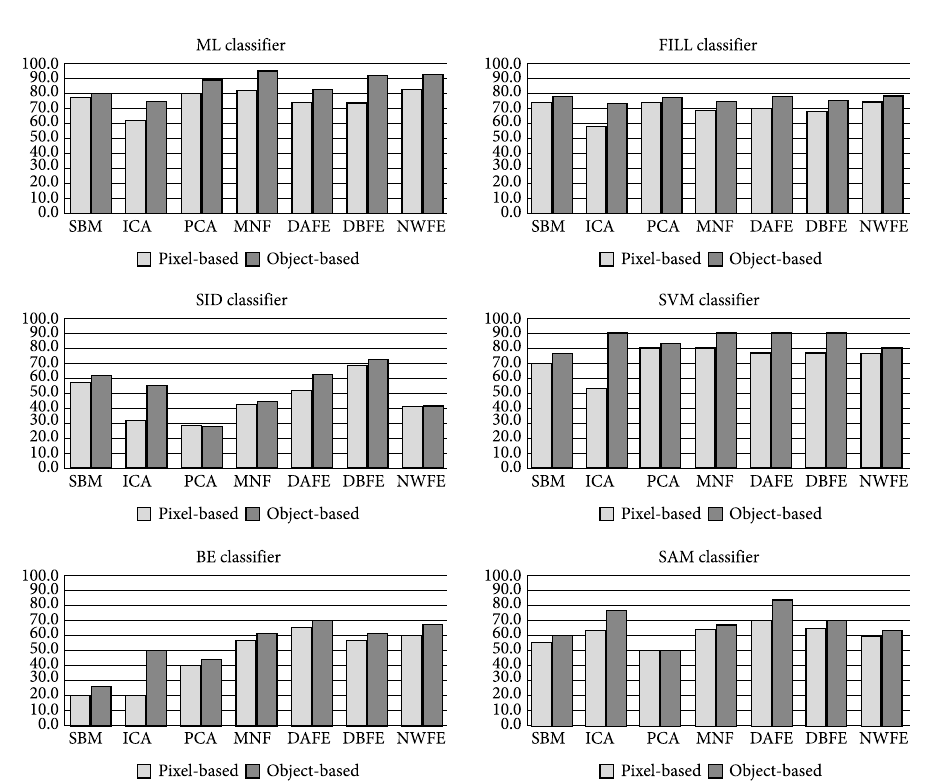
Fig. 5. The overall accuracies of pixel-based vs.